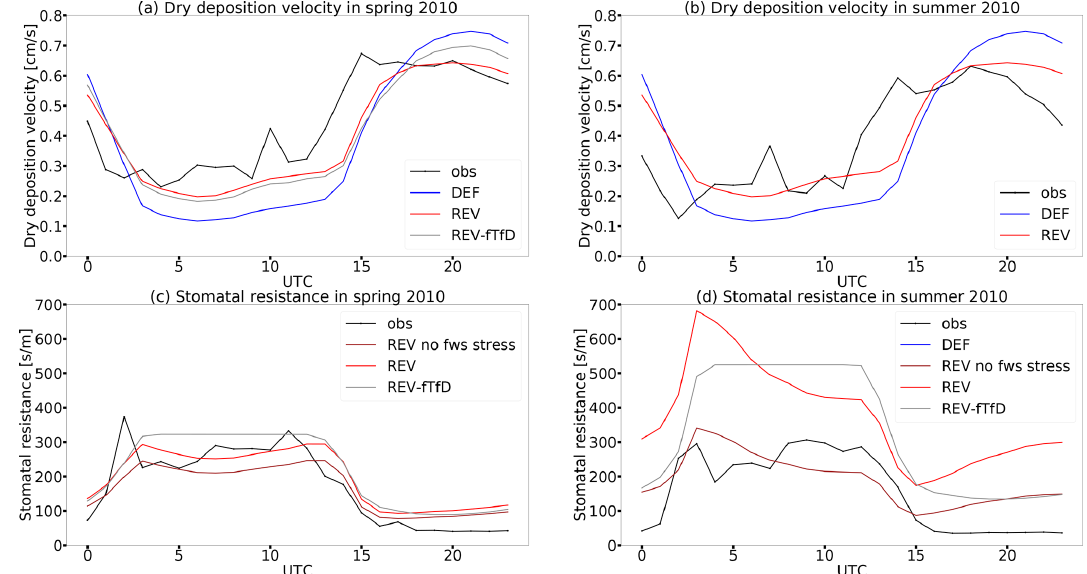
Figure 4. Diurnal cycles of measured (obs) and modelled (DEF, REV, REV-fTfD) ozone dry deposition velocity and stomatal resistance in spring and summer 2010 at Lindcove research station.